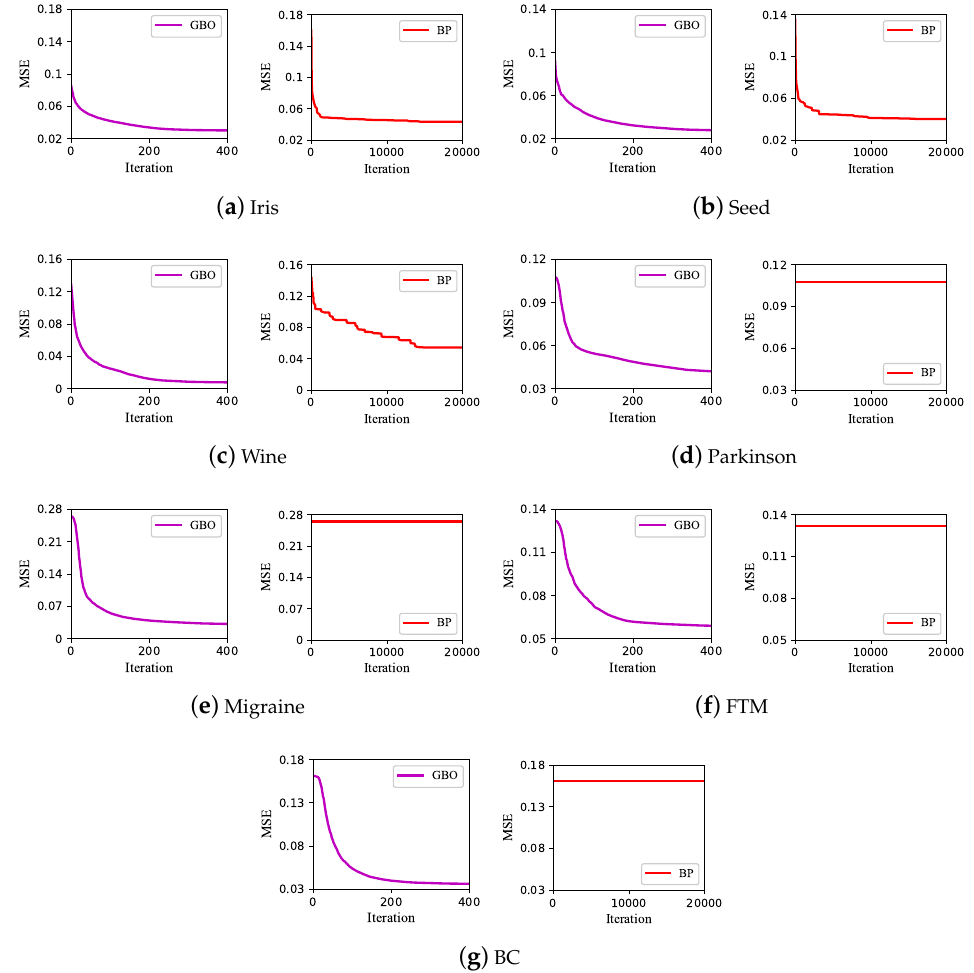
Figure 5. Convergence curves of the GBO algorithm and BP algorithm on the seven